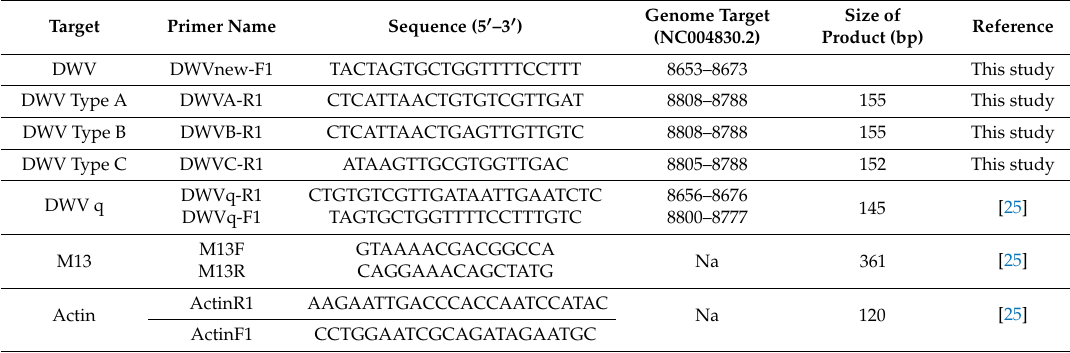
Table 1. Primers used in this